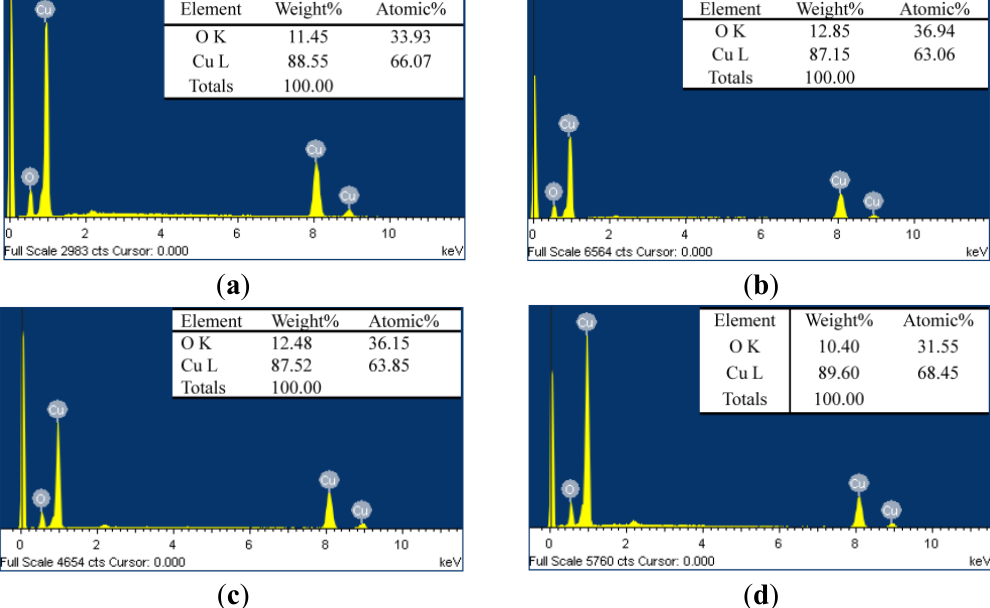
Figure 3. The energy-dispersive X-ray spectroscopy (EDS) analytic results of the Cu 2 O counter electrodes sintered at ( a ) 400 ˝ C; ( b ) 500 ˝ C; ( c ) 600 ˝ C and ( d ) 700 ˝ counter electrodes sintered at ( a ) 400 °C, ( b ) 500 °C, ( c ) 600 °C and ( d ) 700 °C.